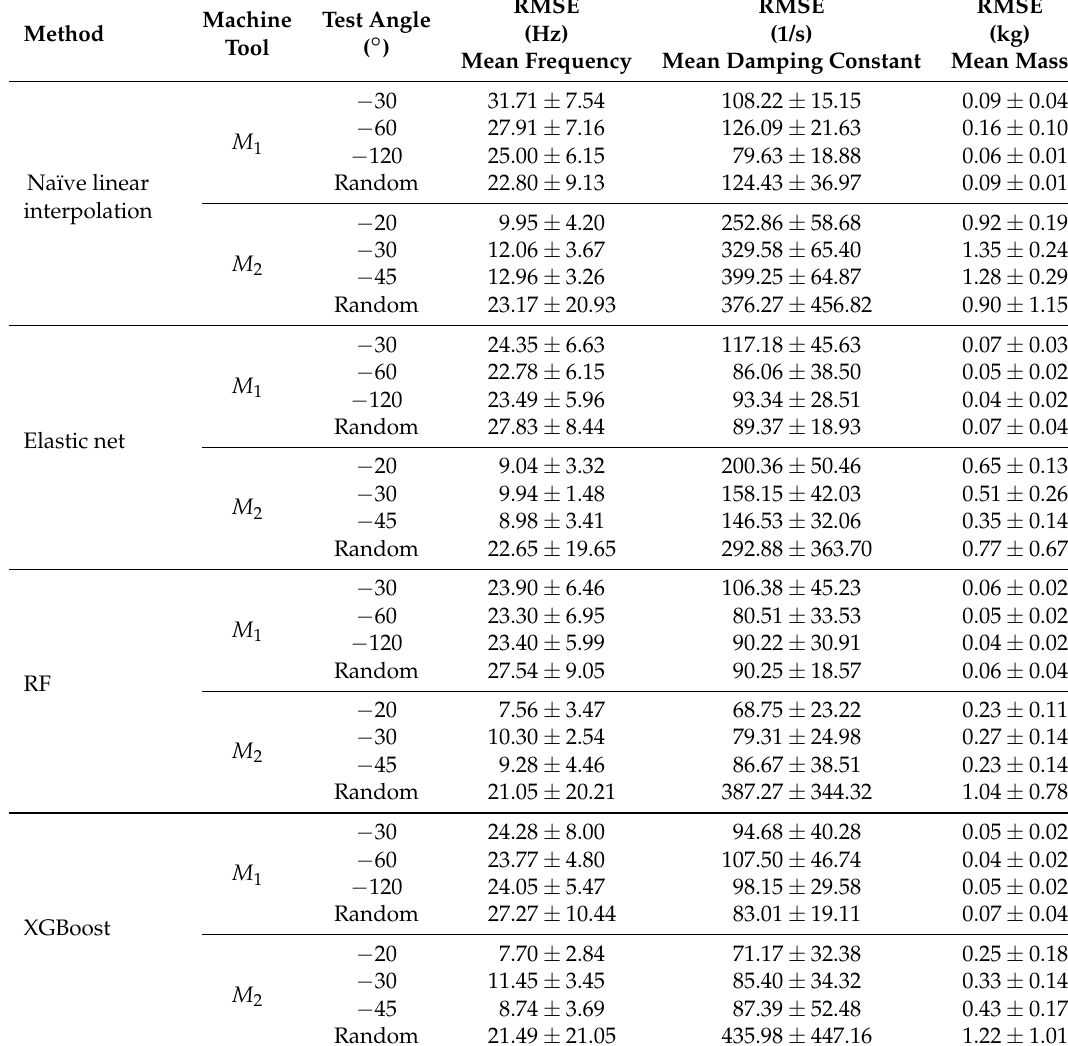
Table 5. Comparison between the RMSE of the predicted modal parameter values for two machine tools using different